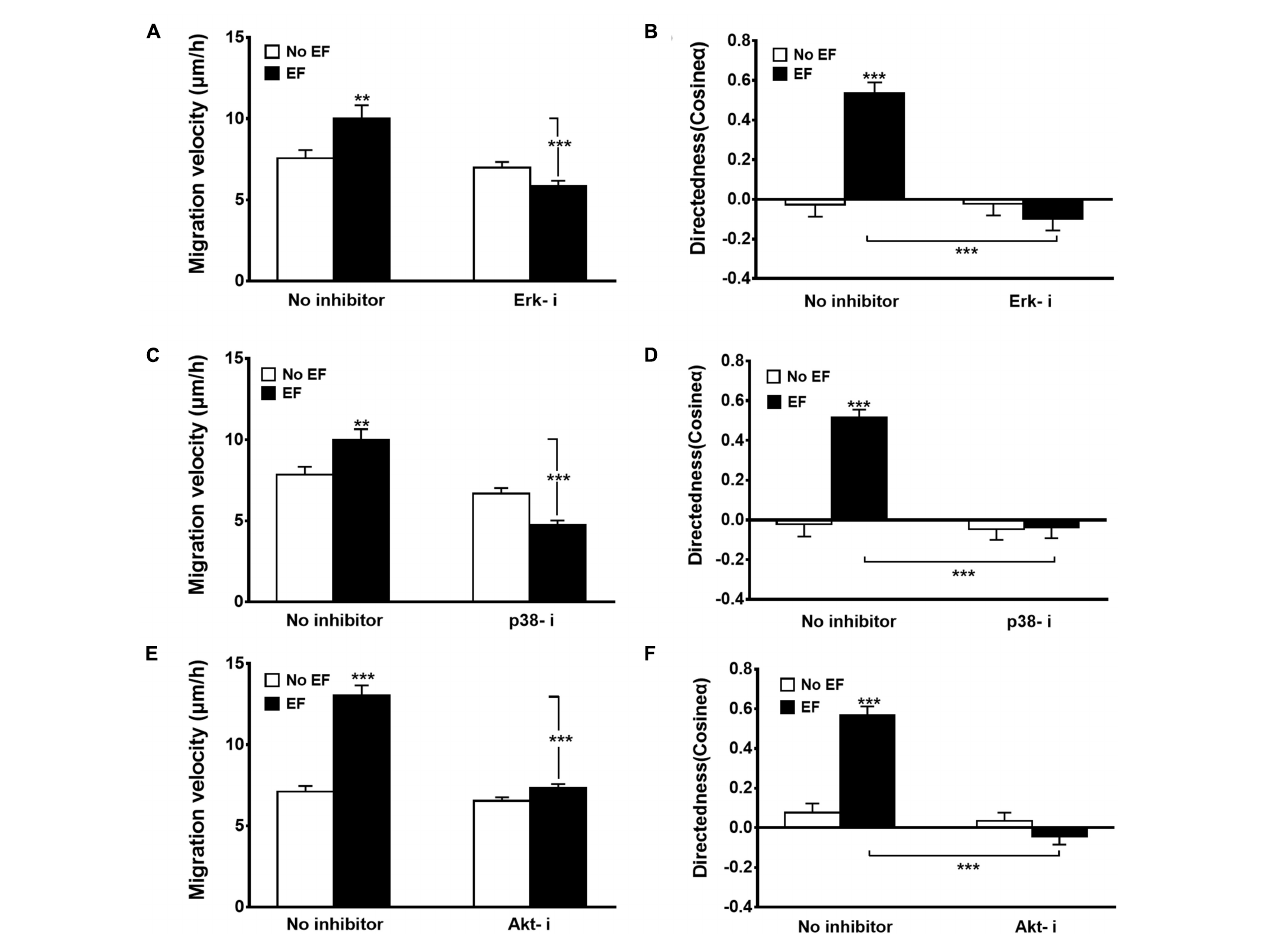
FIGURE 5 | Effects of various inhibitors on EF-induced cellular migration. Inhibition of Erk1/2 (Erk1/2-i), p38 (p38-i), and Akt (Akt-i) significantly decreased migration velocity (A,C,E) and directedness (B,D,F) responses. Erk1/2-i, Erk1/2 MAPK inhibitor U0126 (20 µ M); p38-i, p38 inhibitor SB203580 (50 µ M); Akt-i, Akt inhibitor (10 µ M). HK-2 cells were subjected to EFs of 200 mV/mm for 6 h. n = 64–328 from at least three independent experiments. **P < 0.01, *** P < 0.001, significantly different from values as